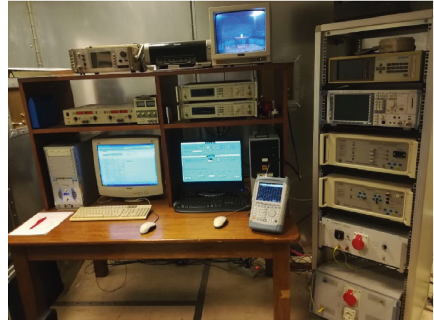
Figure 9: Instrumentations in the prechamber.